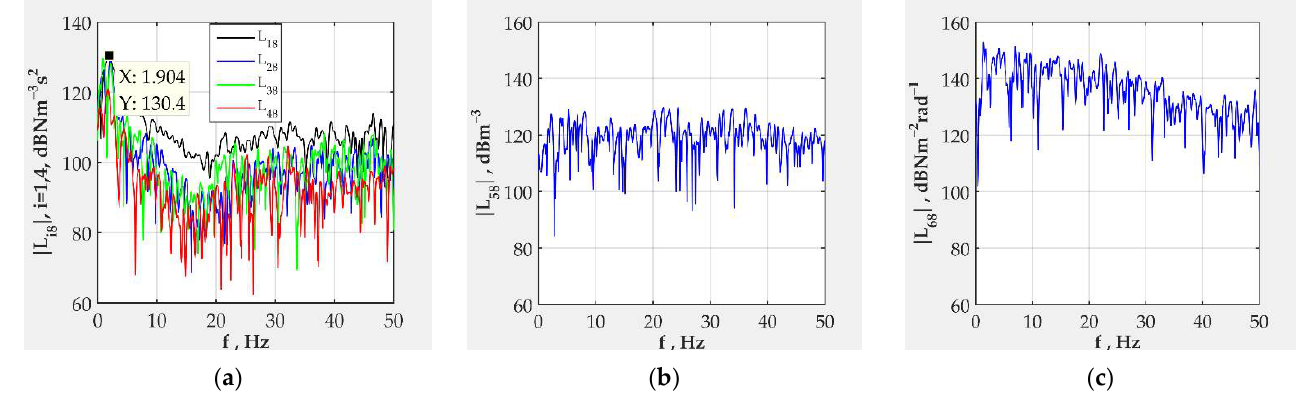
Figure 12. Magnitudes of optimal frequency response functions for the transfer channels: ( a